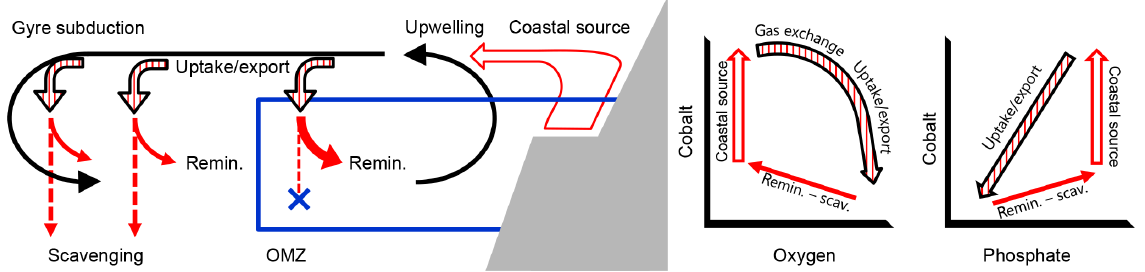
Figure 14. Schematic cross section of the cobalt cycle in the eastern tropical South Pacific. Black arrows describe idealized physical circula- tion, showing upwelling near the Peru margin, advection westward, and subduction in the South Pacific gyre. Biological Co export is shown in the red-striped arrows, and solid and dashed red arrows show remineralization and scavenging, respectively. The margin source is shown as a red-outlined arrow. These vectors are also plotted on idealized oxygen and phosphate axes, using the same color scheme, to show how these processes appear in Co : O 2 and Co : PO 4